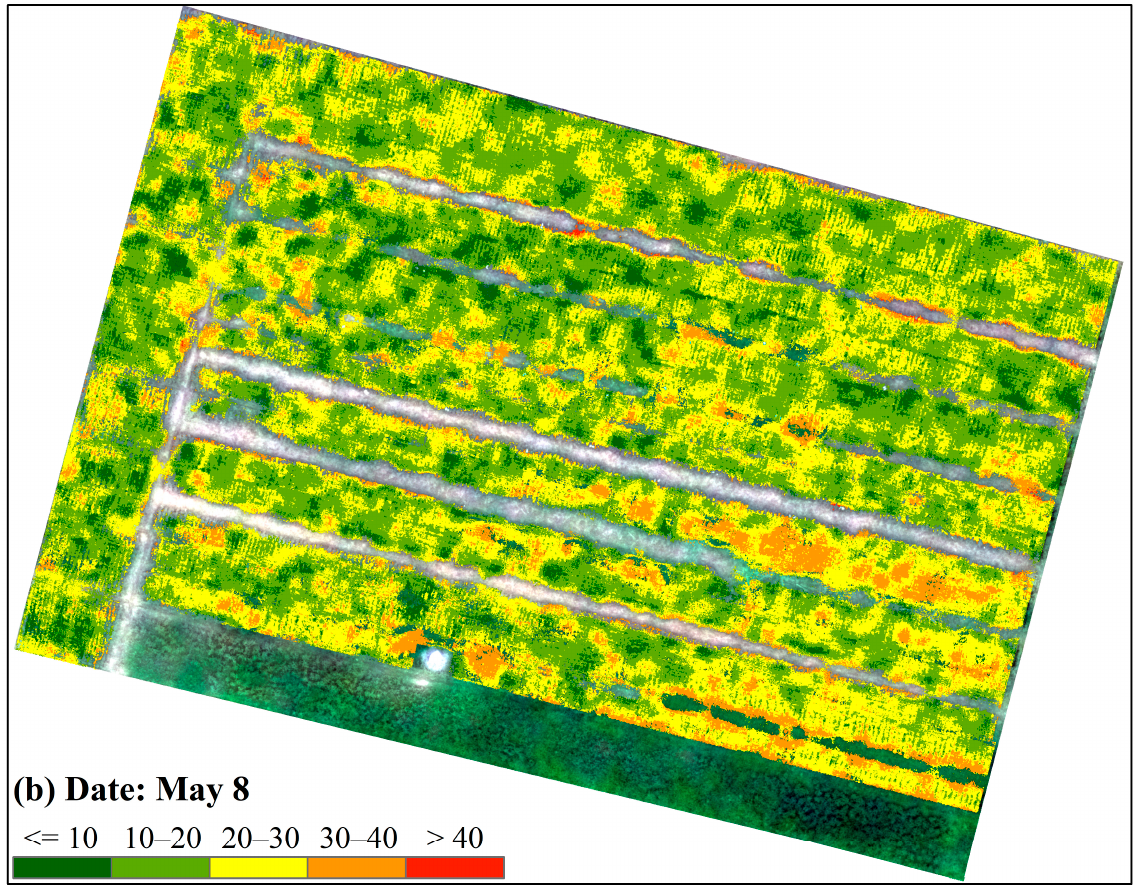
Figure 6. Damage maps of wheat FHB on ( a ) 3 May and ( b ) 8 May 2019, obtained using the normalized (SBs + VIs + WFs)-based SVM detection model. Table 3. Area proportions with different FHB infection levels on 3 May and 8 May 2019.